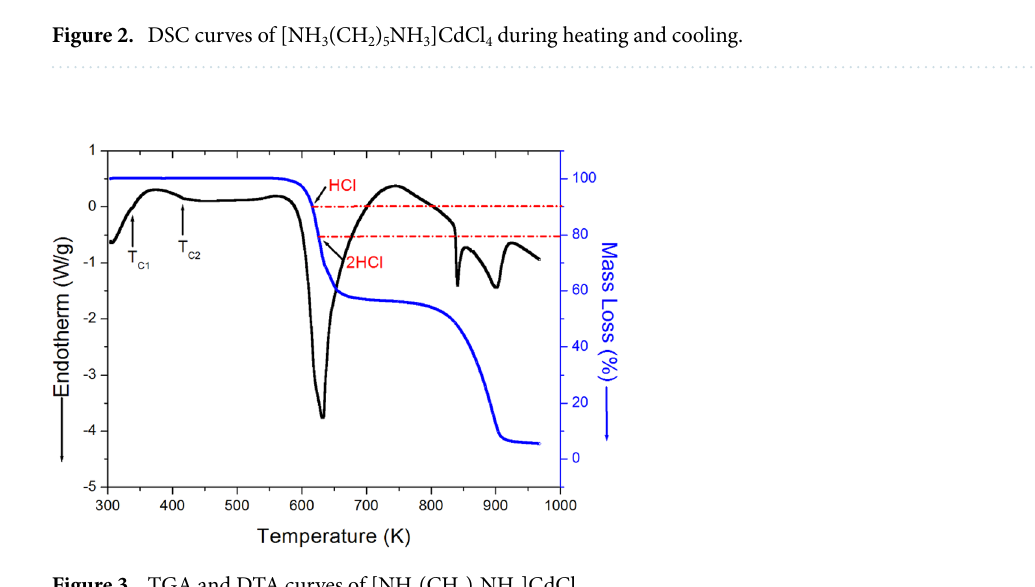
Figure 3. TGA and DTA curves of [NH 3 (CH 2 ) 5 NH 3 ]CdCl 4